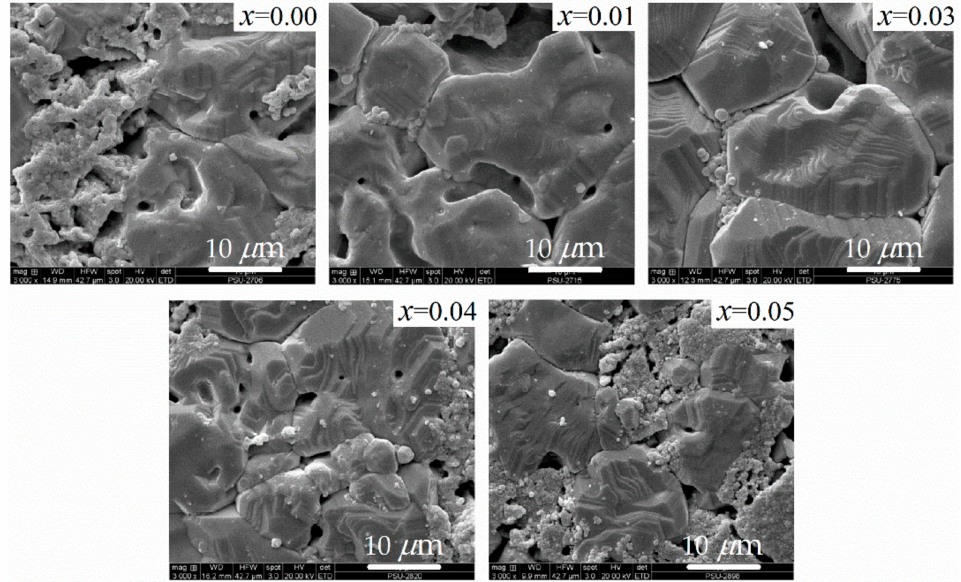
Figure 3. SEM images of the sintered Ba(Zr x Ti 1 − x )O 3 ceramics. Table 1. Relative density, the values of the dielectric constant ( ε r ) at T m (1 kHz), dielectric loss (tan δ ) at T m (1 kHz), Curie–Weiss temperature ( T 0 ), Curie–Weiss constant ( C ), Curie–Weiss law temperature ( T cw ), T m , ∆ T m , and γ for all x values of Ba(Zr x Ti 1 − x )O 3 . Ba(Zr x Ti 1 − x )O